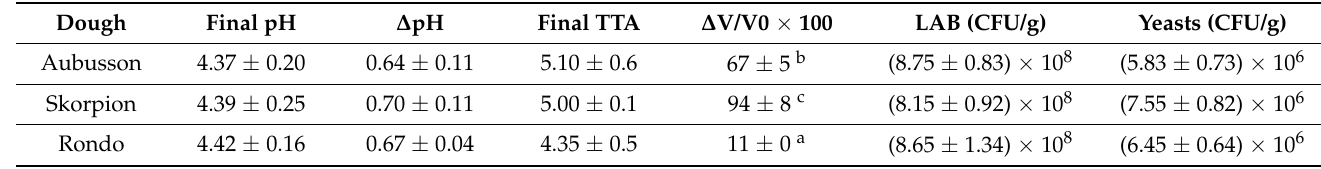
Table 2. Acidification (pH, total titratable acidity), volume increase (%, ∆ V/V0), and microorganism concentrations (LAB and yeast) of the doughs at the end of the 4-h fermentation. ∆ : difference between the final and the initial value. Aubusson: dough with a sourdough made with wheat flour cv Aubusson; Rondo: dough with a sourdough made with barley flour cv Rondo. Results are expressed as average ± standard deviation.